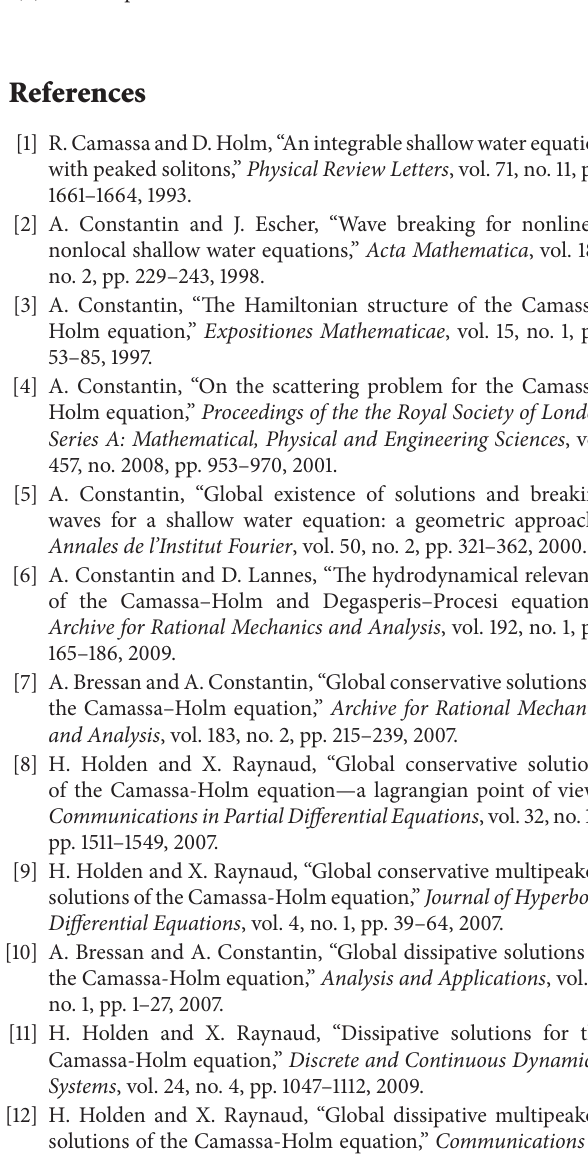
Figure 1: (a) Initial configuration. (b) The two peakons collide.